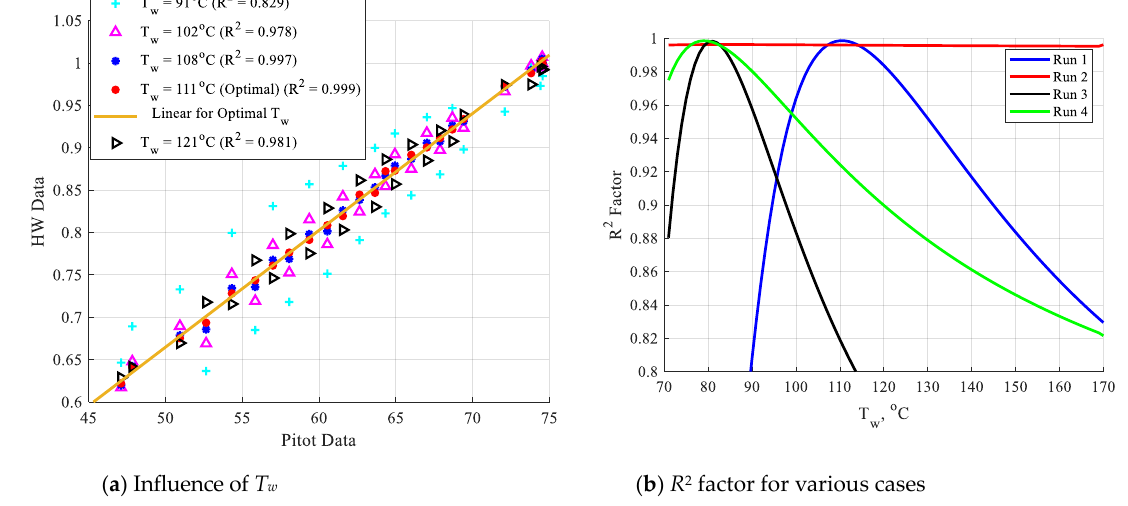
Figure 6. Accuracy of temperature correction by various wire temperatures.